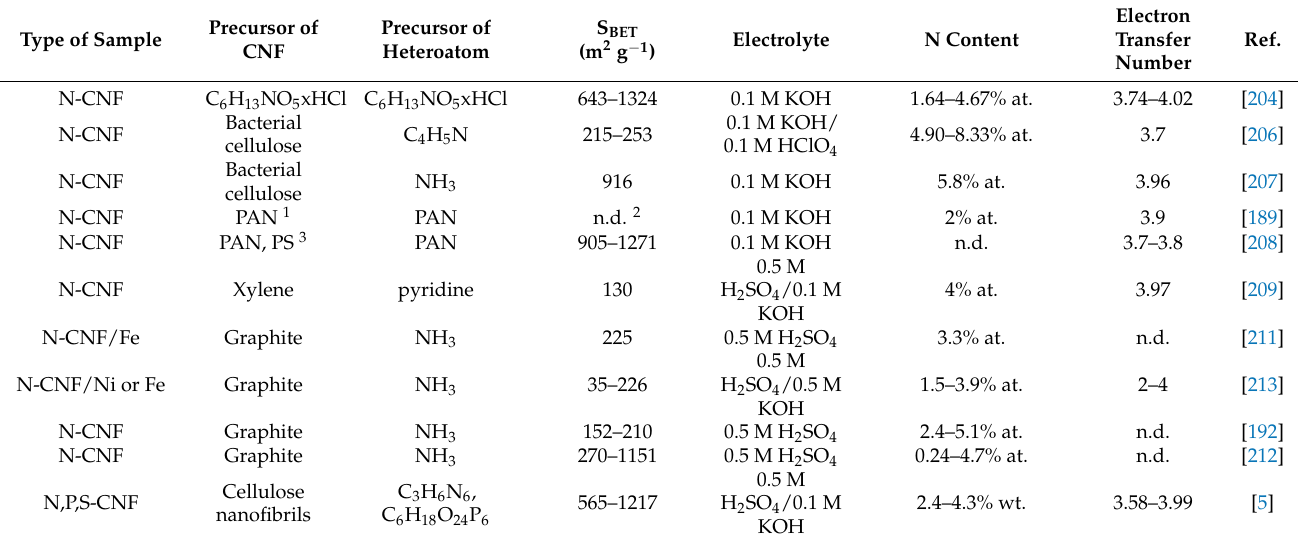
Table 7. Summary of nitrogen-doped carbon nanofibers as electrocatalysts for